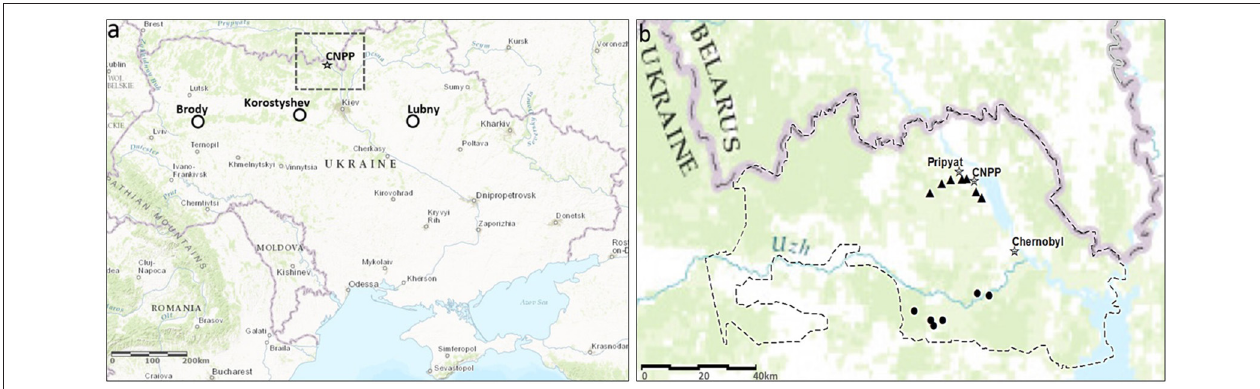
FIGURE 1 | (a) Location of control population trapping sites in Ukraine. (b) Bank vole trapping sites in the Chernobyl Exclusion Zone (CEZ). Background radiation intensity is shown as circles ( < 1.0 µ Gy/h) and as triangles (up to 12.3 µ Gy/h). Created using ESRI ArcGIS 10.5. Satellite imagery © .